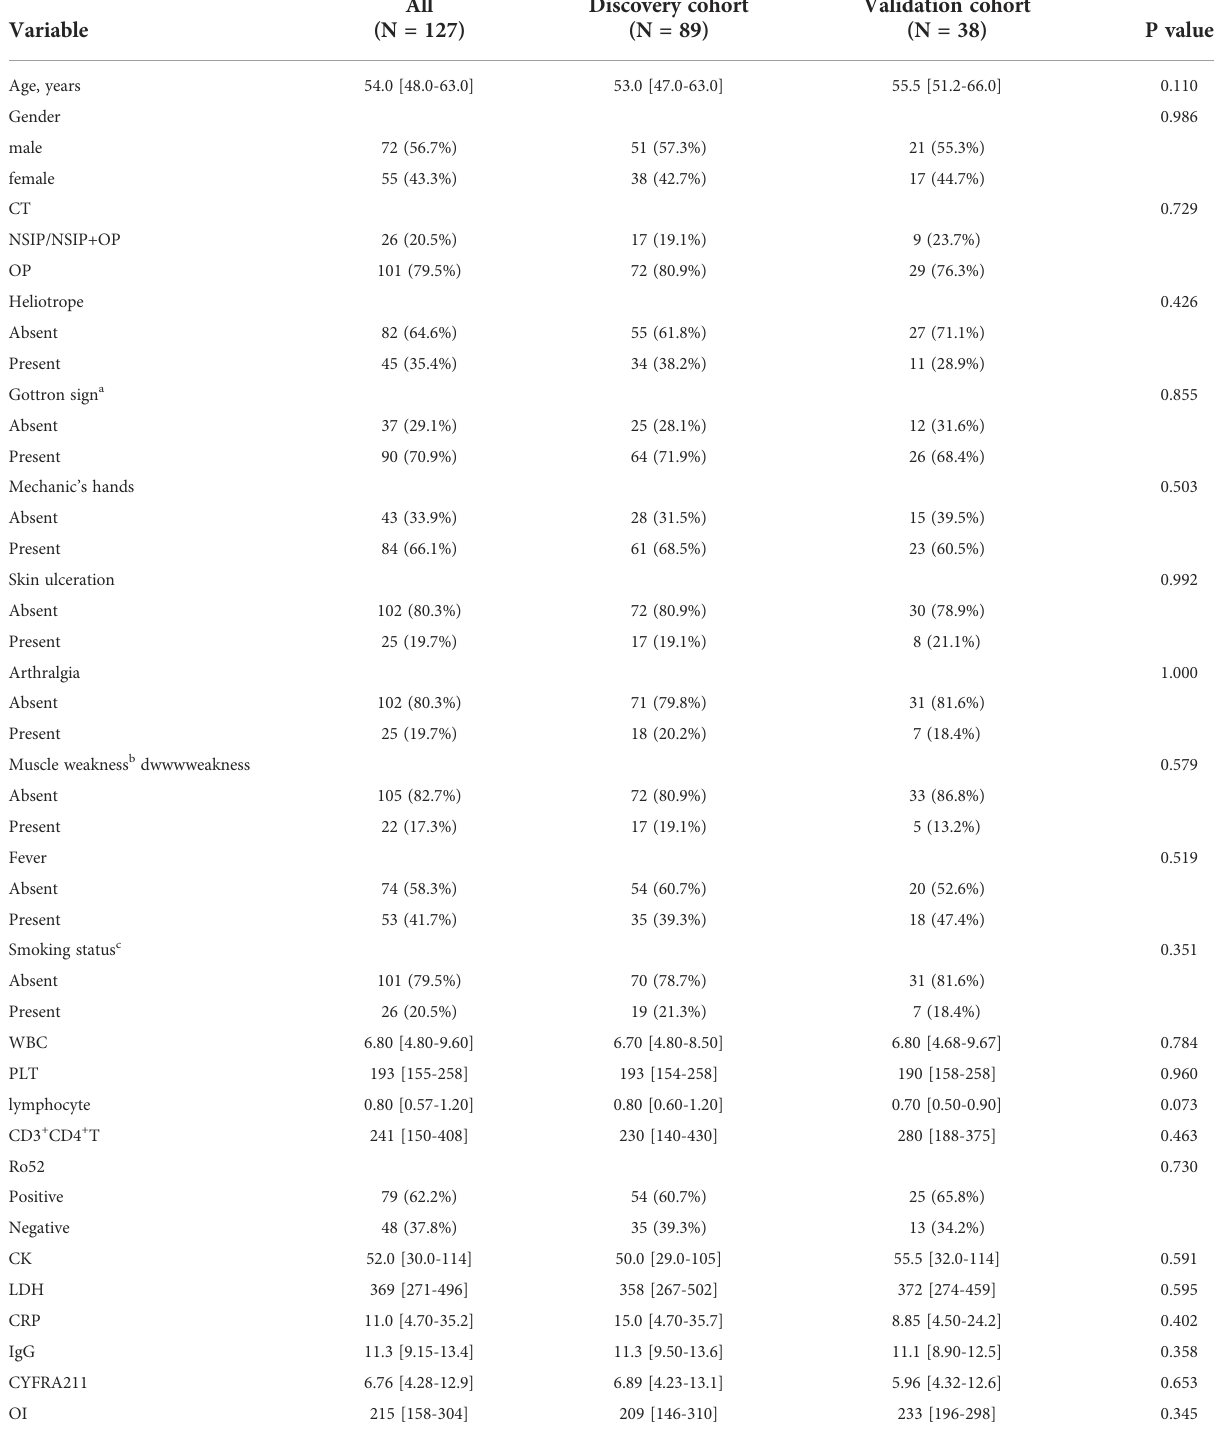
TABLE 1 Patient characteristics and treatments in discovery and temporal validation